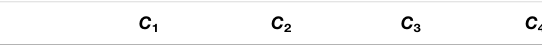
TABLE 5 | Determination of fatigue damage parameters.